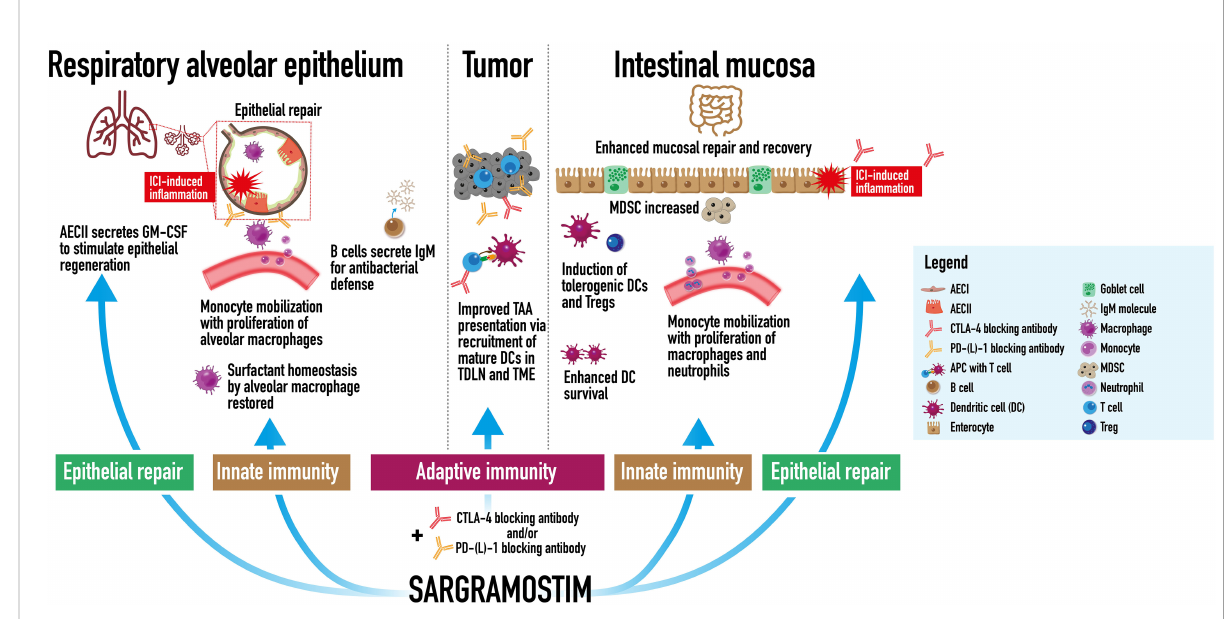
FIGURE 3 Possible antitumor and restorative activity of sargramostim in immune checkpoint inhibitor combination therapy. In checkpoint-induced pneumonitis, sargramostim (recombinant human granulocyte-macrophage colony-stimulating factor; rhu GM-CSF) may stimulate epithelial regeneration as modeled by endogenous GM-CSF-secreting Type II alveolar epithelial cell (AECII). Monocyte and alveolar macrophage mobilization and functional restoration of alveolar macrophages (which express programmed cell death protein 1 [PD-1] receptors) may contribute as well. Restoration of surfactant homeostasis by alveolar macrophages may support barrier renewal. Sargramostim may reinforce antibacterial defense via immunoglobulin M (IgM) secretion from B cells. Potential antitumor mechanisms of combination sargramostim and immune checkpoint inhibitor therapy may include improved tumor-associated antigen (TAA) presentation via recruitment of mature dendritic cells (DCs) in the tumor draining lymph node (TDLN) and tumor microenvironment (TME). In immune-mediated colitis, sargramostim mayenhance mucosal repair and recovery via induction of tolerogenic DCs and regulatory T cells (Tregs), and enhanced DC survival. Monocytes, macrophages, and neutrophils may be mobilized to bolster antibacterial defenses. Myeloid derived suppressor cells (MDSC) may be increased to enhance anti-in fl ammatory response. AECI, Type I alveolar epithelial cell; AECII, Type II alveolar epithelial cell; CTLA-4, cytotoxic T- lymphocyte associated protein-4; GM-CSF, granulocyte-macrophage colony-stimulating factor; ICI, immune checkpoint inhibitor; IgM, immunoglobulin M; PD-1, programmed death-1; PD-L1, programmed death